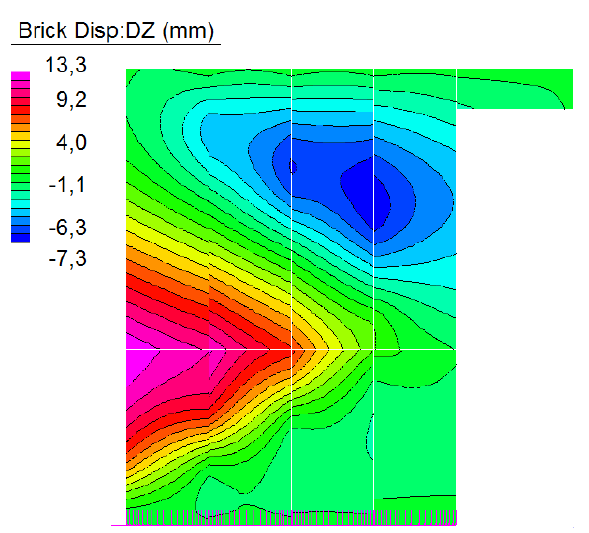
Fig. 16 Horizontal out-of-plane displacement of the central laminated glazing – load combination SLS